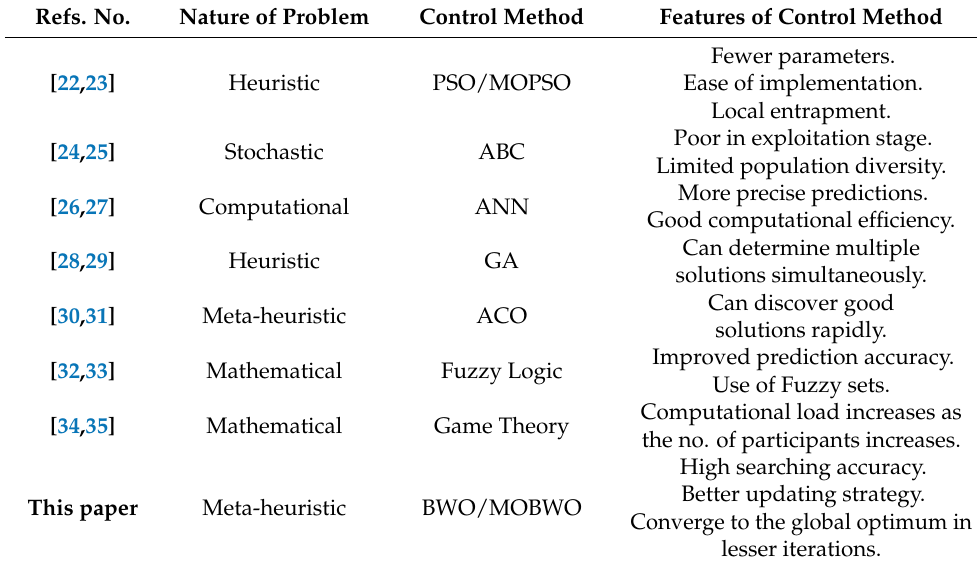
Table 1. Control methods employed for optimal scheduling purposes. Refs. No. Nature of Problem Control Method Features of Control Method Heuristic